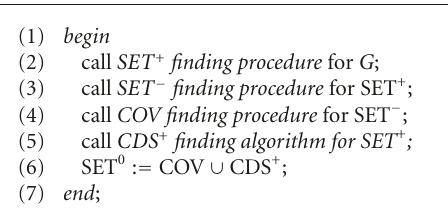
Algorithm 6: The algorithm for finding a BACDS in graph G